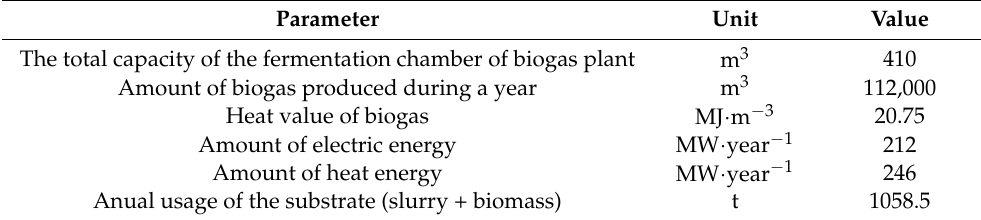
Table 1. Technological data of biogas plant (own study). Parameter